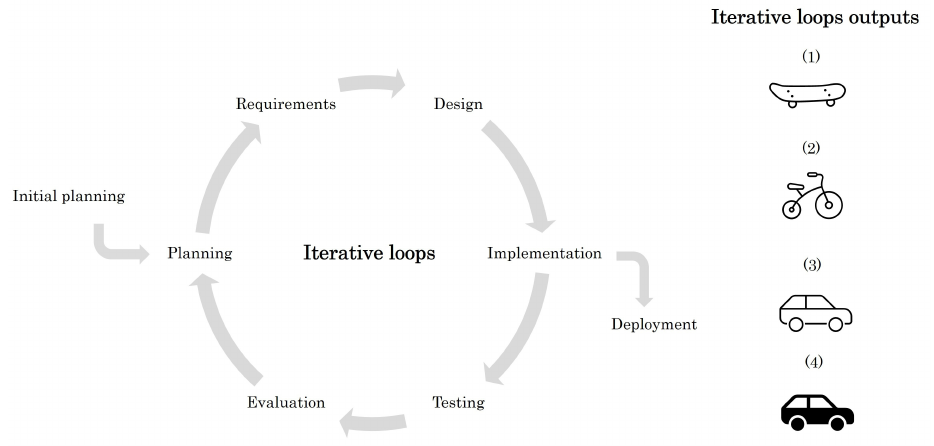
Figure 3. Iterative model and its four outputs identified as